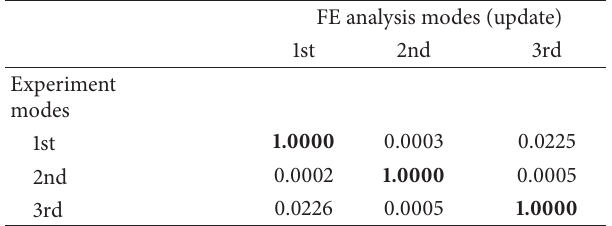
Table 11: MAC values (updating and